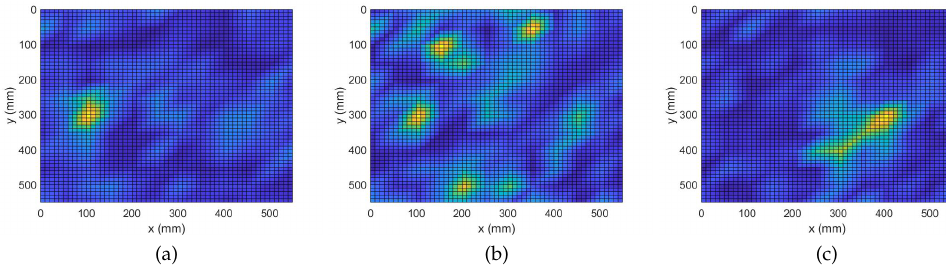
Figure 4. Damage Detection with Adaptive Complex Group Lasso. ( a ) M 1 : 1 point-like mass. ( b ) M 4 : 4 point-like masses. ( c ) M E : 1 extended